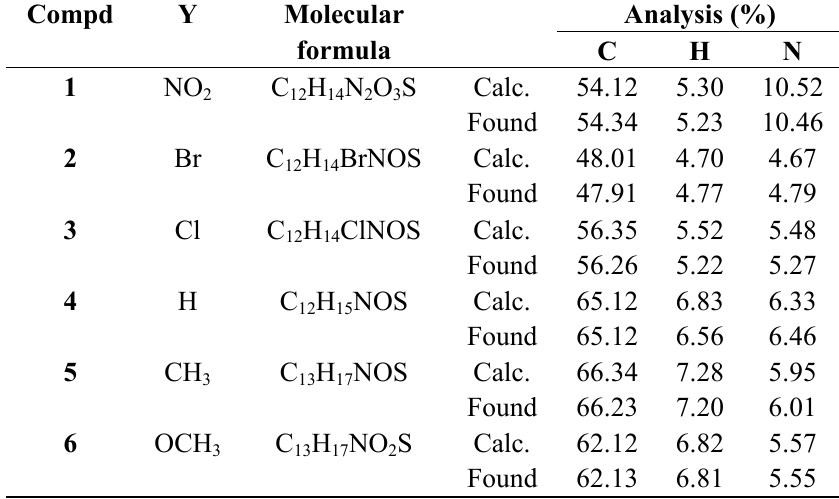
Table 7. Elemental analysis data for 3-[(4 ′ -substituted-phenyl)sulfanyl]-1-methyl-2- piperidones 1 – 6